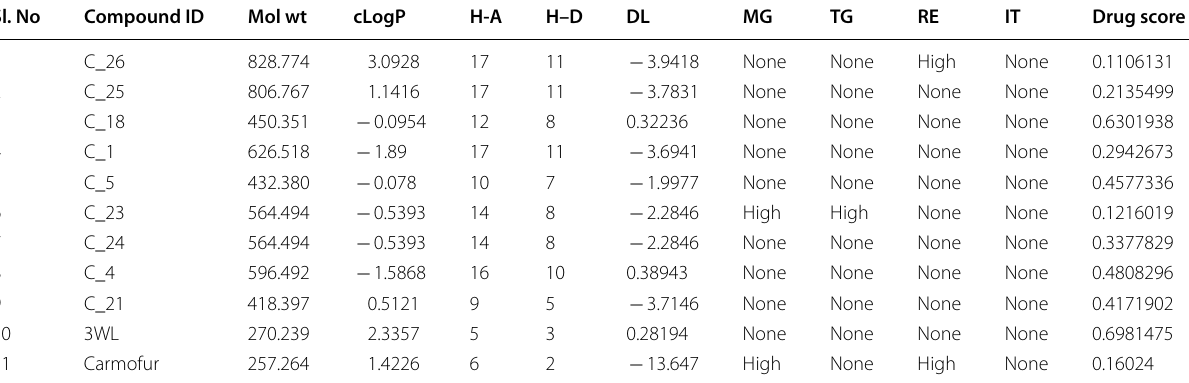
Mol wt. Molecular weight; cLogP = MG Mutagenicity; TG =